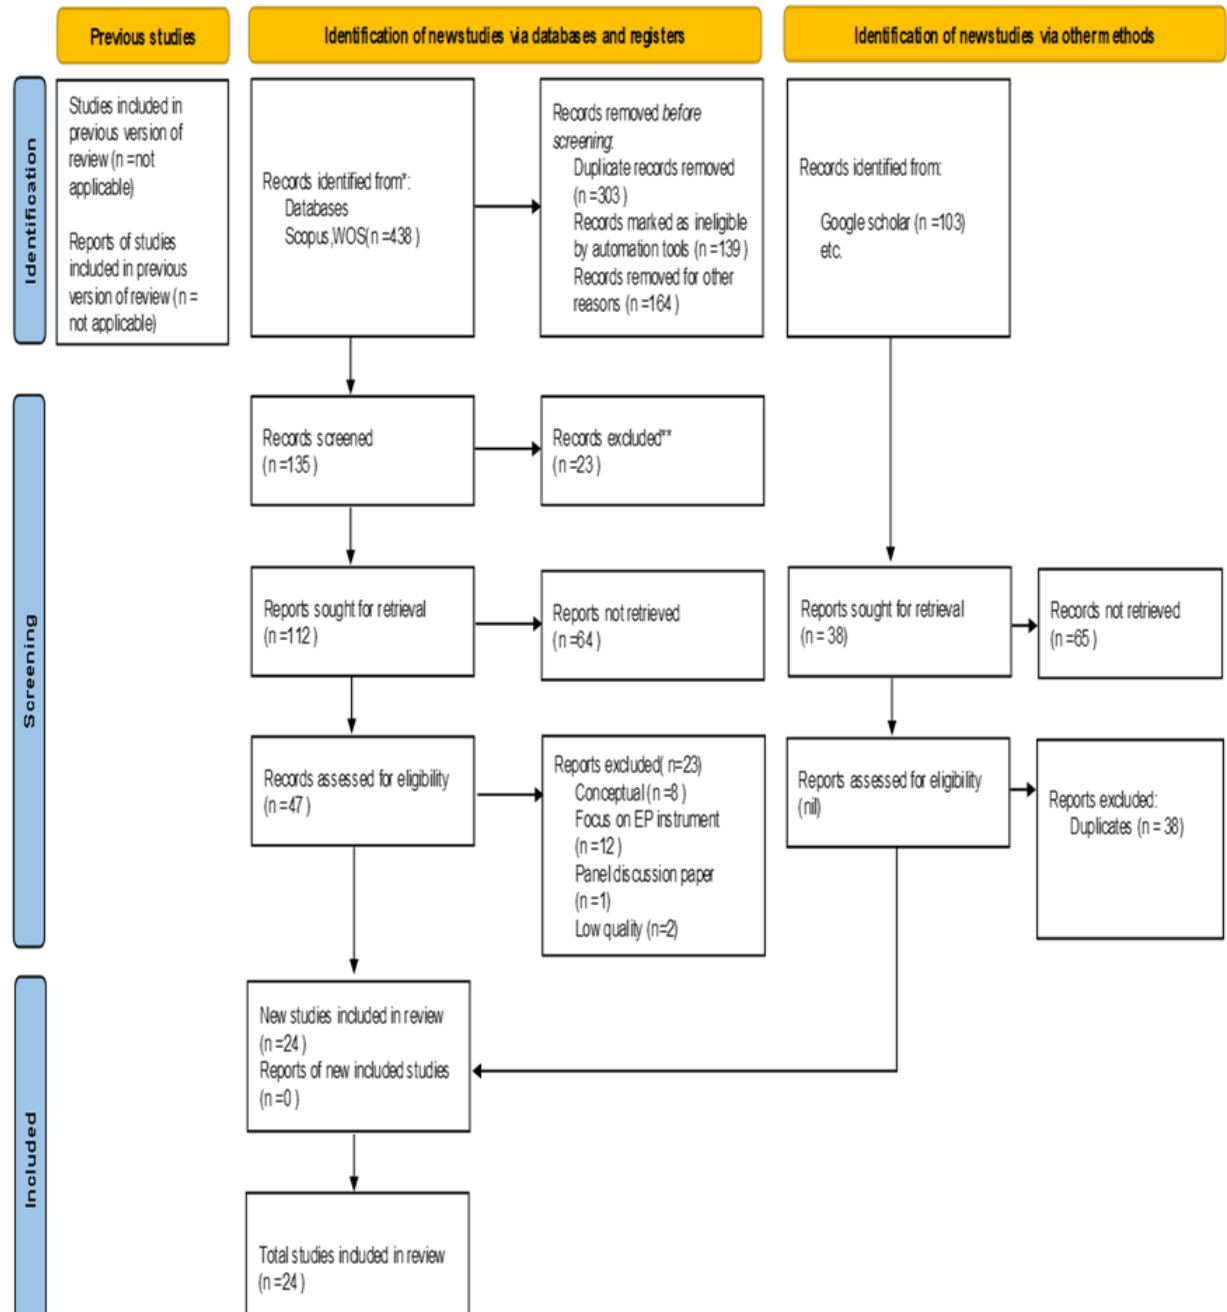
Figure 1. Screening process flow (adapted from PRISMA 2020 diagram flow).